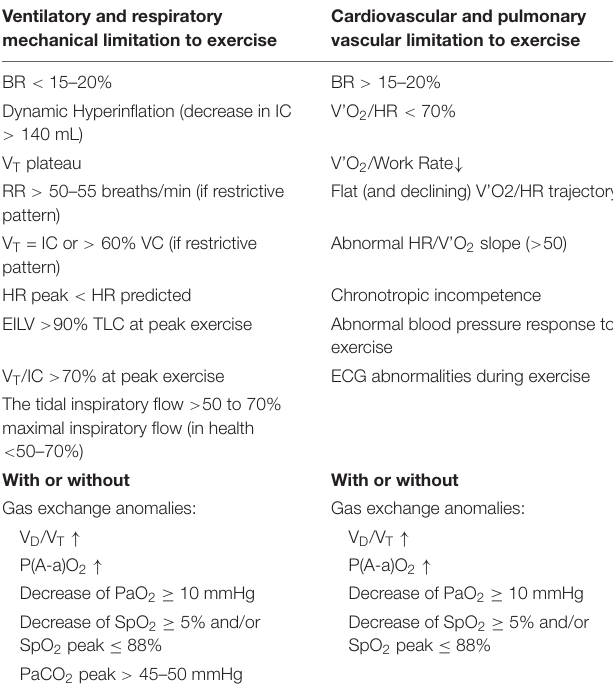
TABLE 1 | Variables defining ventilatory and respiratory mechanical limitation (left panel) accompanied or not by gas exchange anomalies to exercise, and variables defining cardiovascular and pulmonary vascular limitation (right panel) accompanied or not by gas exchange anomalies to